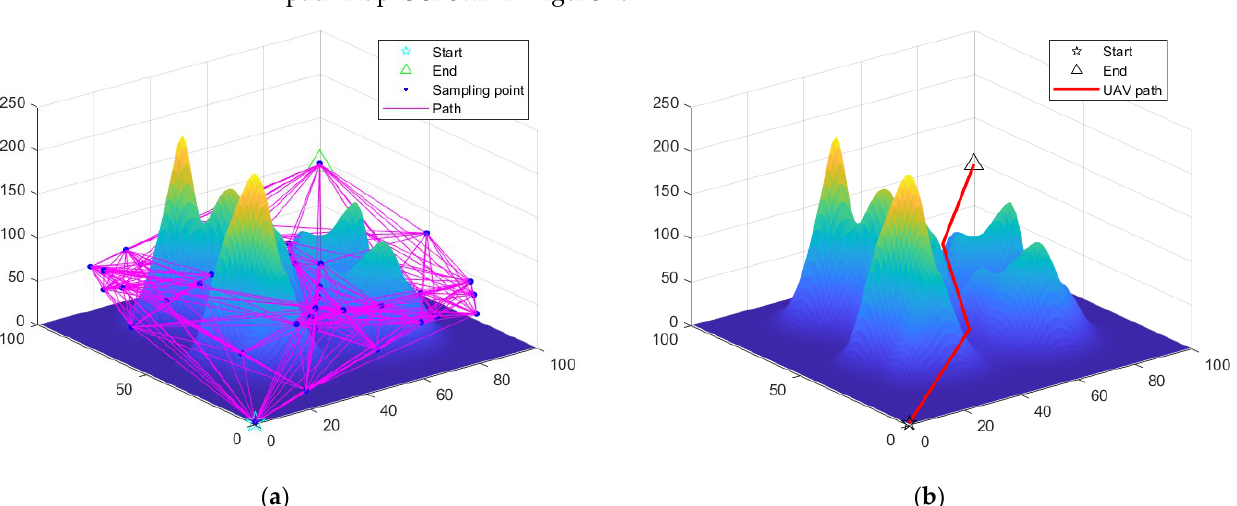
Figure 5. IGA algorithm: ( a ) path graph; ( b ) curve of iteration.